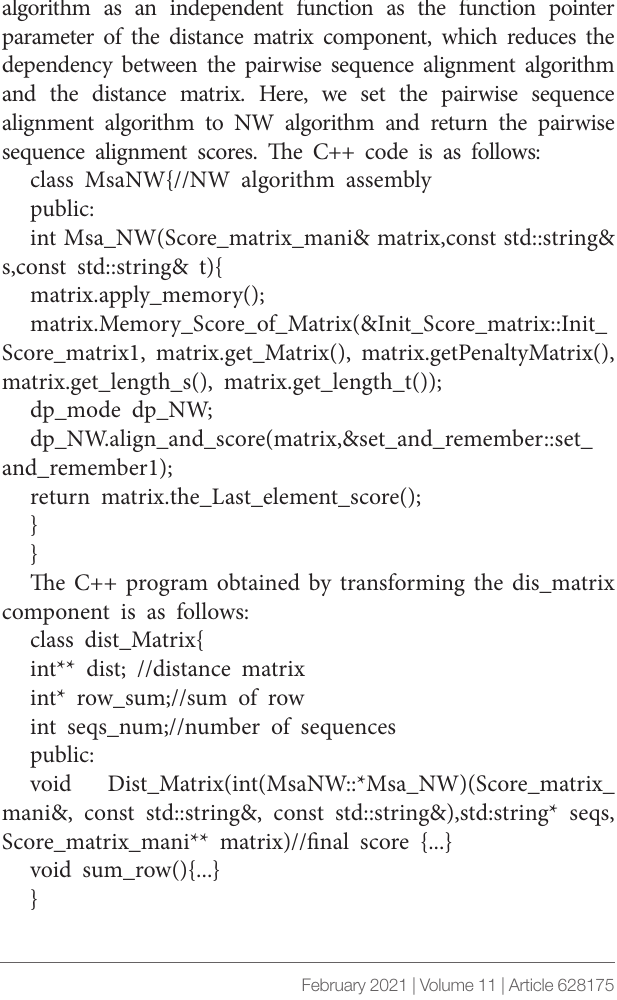
algorithm as an independent function as the function